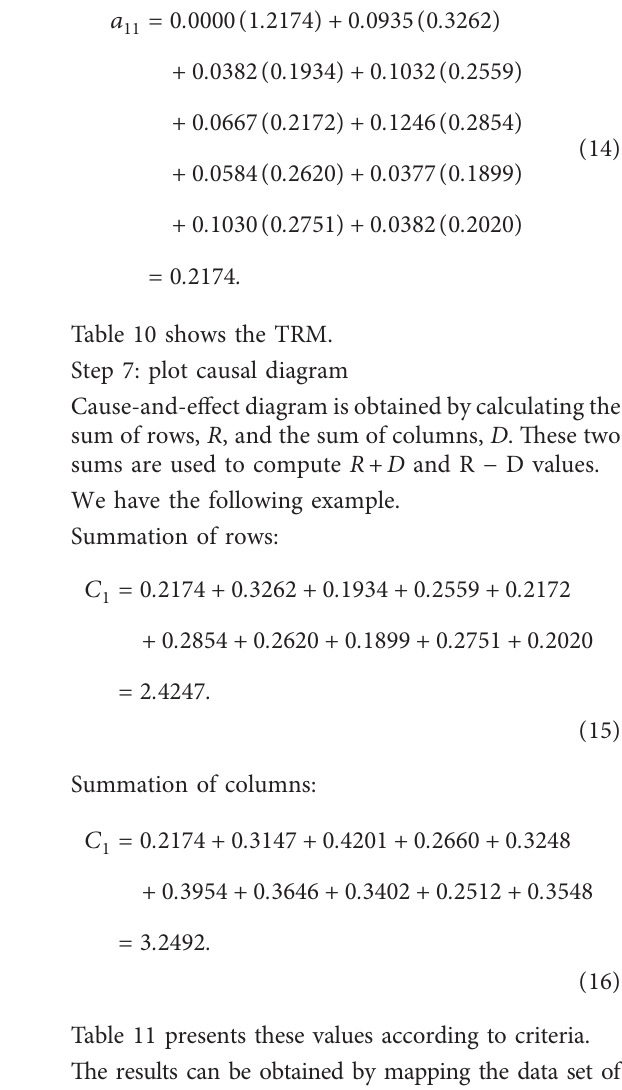
Table 8: Summation of rows and columns. Criteria